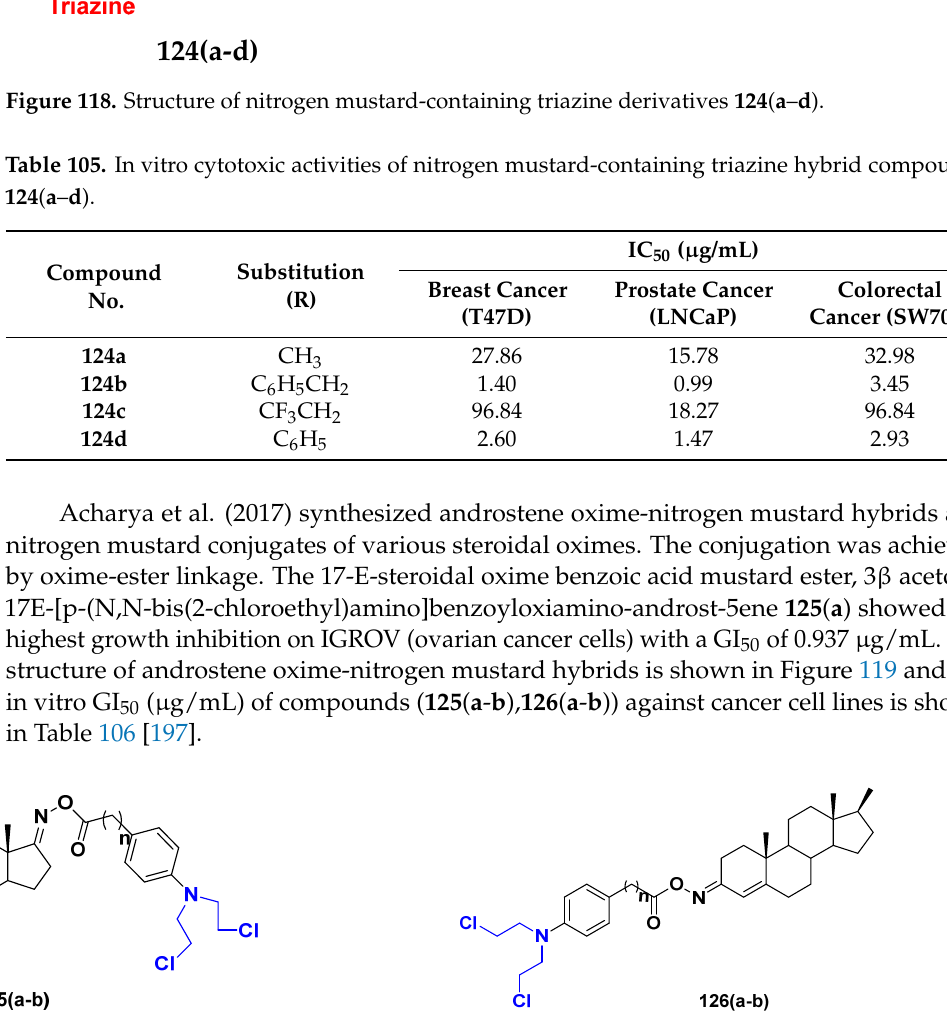
Figure 119. Structure of androstane oxime-nitrogen mustard hybrids [ 125 ( a - b ), 126 ( a - b )]. Table 106. In vitro cytotoxic activities of androstane oxime-nitrogen mustard hybrid compounds [ 125 ( a-b ) ,126 ( a-b )].